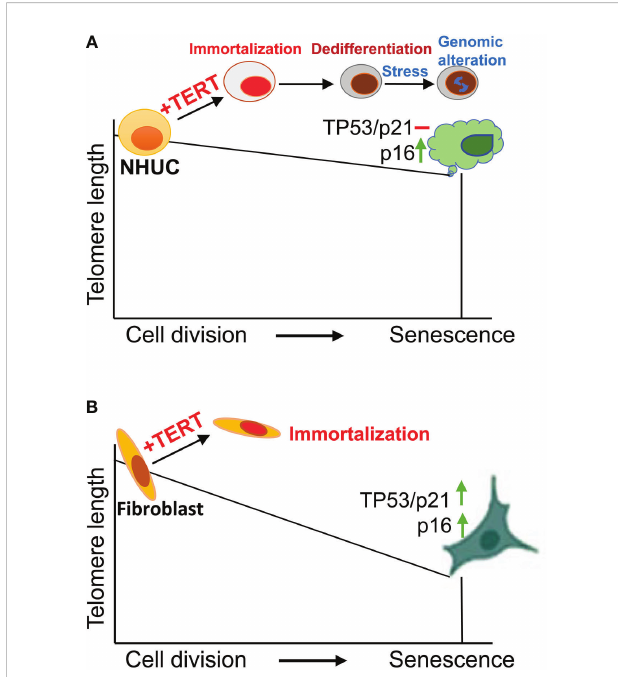
FIGURE 1 Normal human urothelialcell (NHUC)senescence andTERT-mediated immortalization. (A) NHUCsundergoupto30populationdoublings(PDs) and thenenterasenescence stage. SenescentNHUCsexpresshigh levels ofp16without TP53-p21activationand signi fi cantlyshortenedtelomeres. Ectopicexpressionof TERTleadstoimmortalizationanddifferentiation blockadeofpresenescentNHUCs. Stressedcultureconditionstrigger genomicalterationspartially recapitulatingwhat happeninprimaryUC tumors. (B) Unlike NHUCs,senescenthuman fi broblasts exhibitsubstantial telomere erosionwithrobust upregulationofbothTP53andp16.TERT overexpressionsimilarlyimmortalizes fi